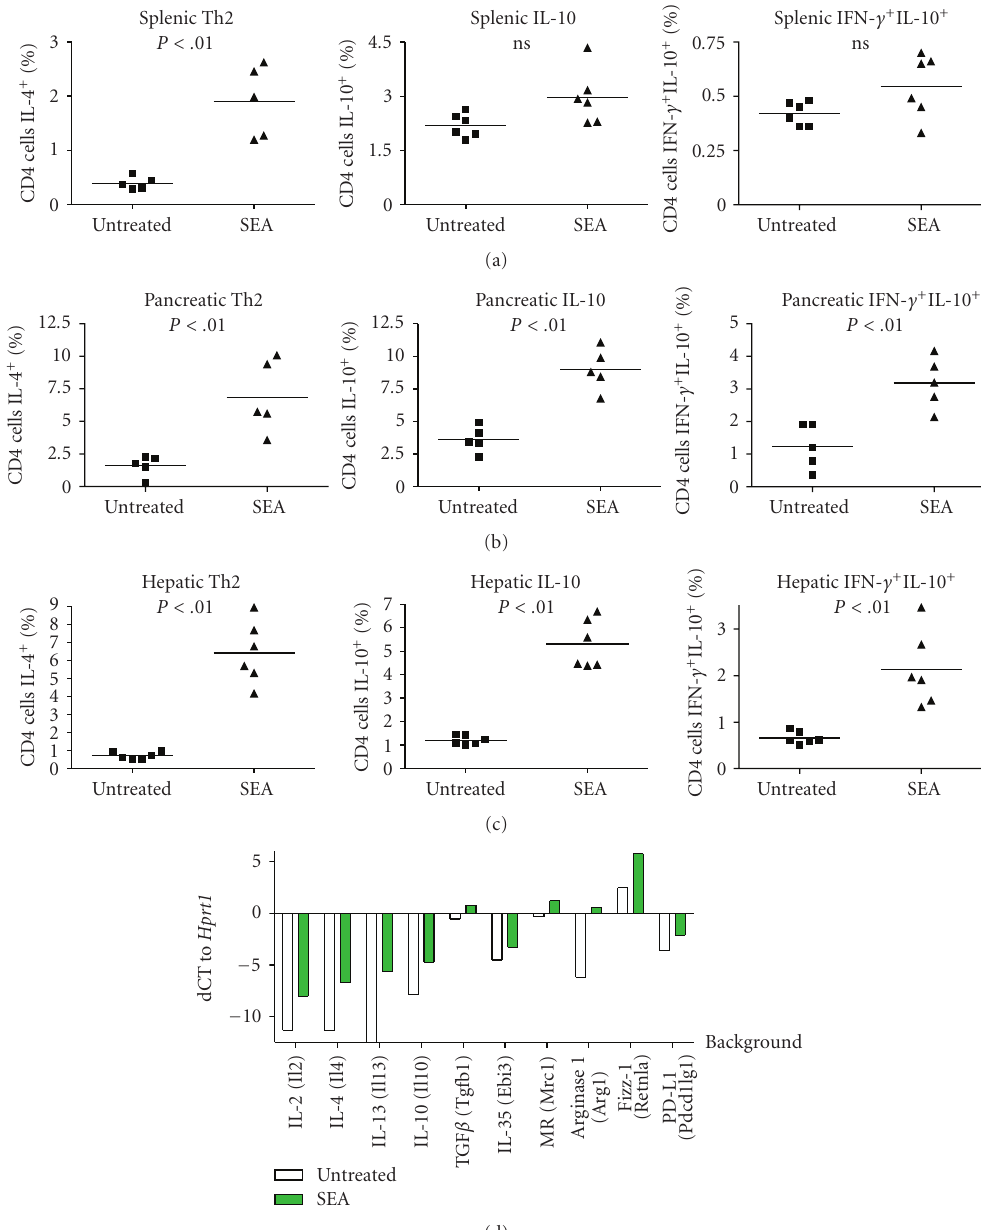
Figure 4: The systemic Th2 response to SEA is accompanied by local induction of IL-10 in the pancreas and liver. Increased proportions of CD4 + T cells expressing IL-4 were seen in the spleen (a), the pancreas (b), and the liver (c). In the pancreas and liver, SEA treatment triggered IL-10 production from Th1 cells. (d) Increased mRNA for Th2 and regulatory cytokines in the pancreas of mice treated with schistosome antigens are shown. Six-week-old female NOD mice were injected i.p. with 50 μ g SEA on day 0 and day 7, and lymphocytes from spleen, pancreas, and liver were collected for FACS and RT-qPCR analysis on day 10. Data shown are the responses of 5-6 mice per group for (a)–(c) or a pool of three mice per condition for (d). Statistical analysis by Mann Whitney U test, two-tailed.